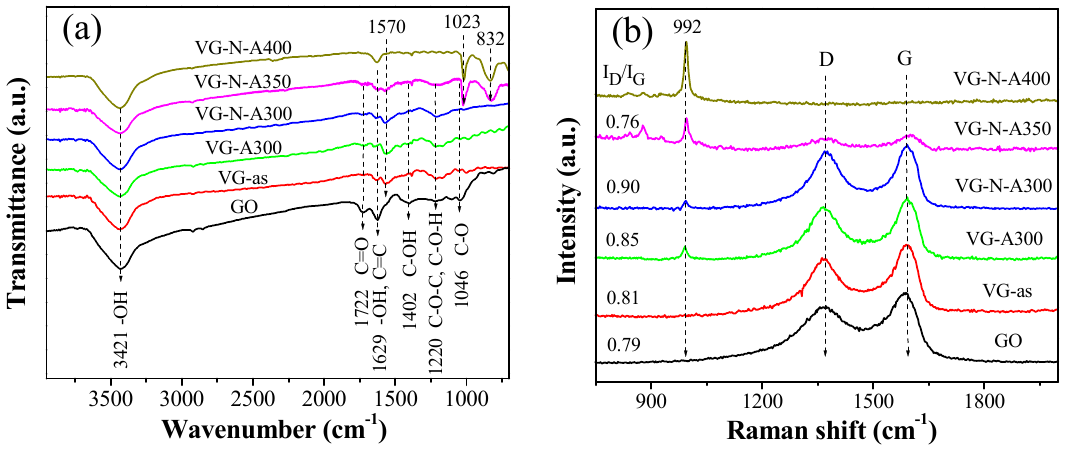
Figure 4. Fourier translation infrared spectroscopy (FT-IR) spectra ( a ) and Raman spectra ( b ) of GO and various VO x /RGO composites.